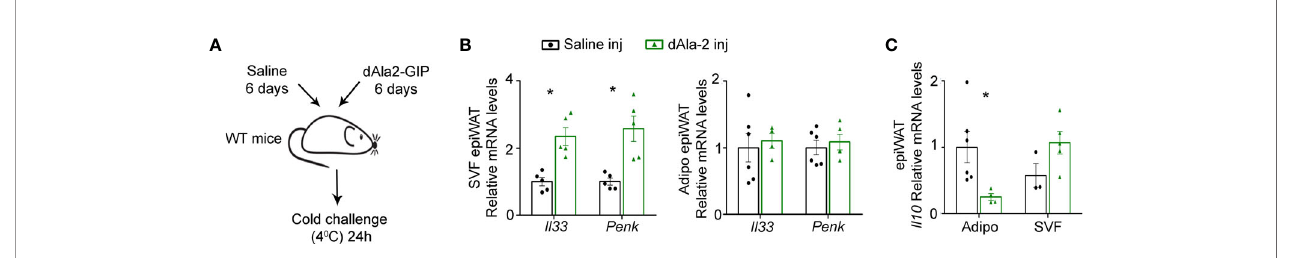
FIGURE 6 | GIP analogue enhances expression of type 2 mediators in epiWAT of lean mice during cold-induced thermogenesis. (A) Scheme illustrating experimental design. WT mice (n= 6) received daily i.p. injections of dAla2-GIP analogue (60 nmol/kg body weight) or vehicle (saline) for 6 days and after that were subjected to cold challenge (4°C) for 24 h. (B) qRT-PCR assessment of the expression of Il33 and Penk genes in isolated adipocyte fraction and SVF of epiWAT normalized to Rplp0 . (C) Expression of Il10 in isolated adipocyte fraction and SVF of epiWAT of these mice was analyzed by qRT-PCR and normalized to Rplp0 . Data are from a single experiment and analyzed by unpaired, 2-tailed t -test and presented as mean ± SEM. *p ≤